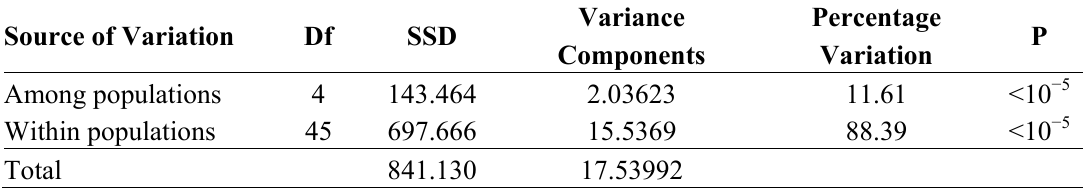
Table 4. Analysis of molecular variance (AMOVA) for five alfalfa